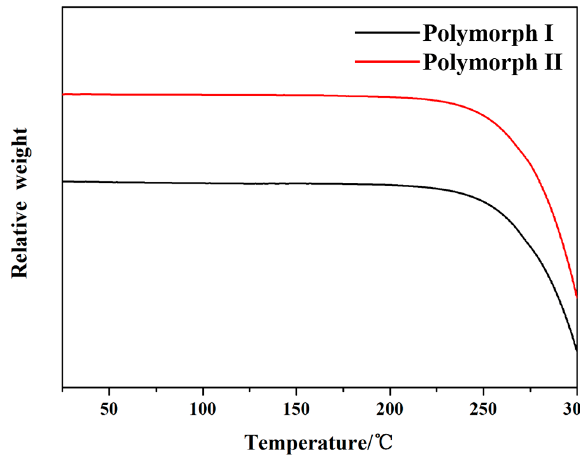
Figure 3. SEM of theophylline. ( a ) Polymorph I; ( b ) polymorph II.